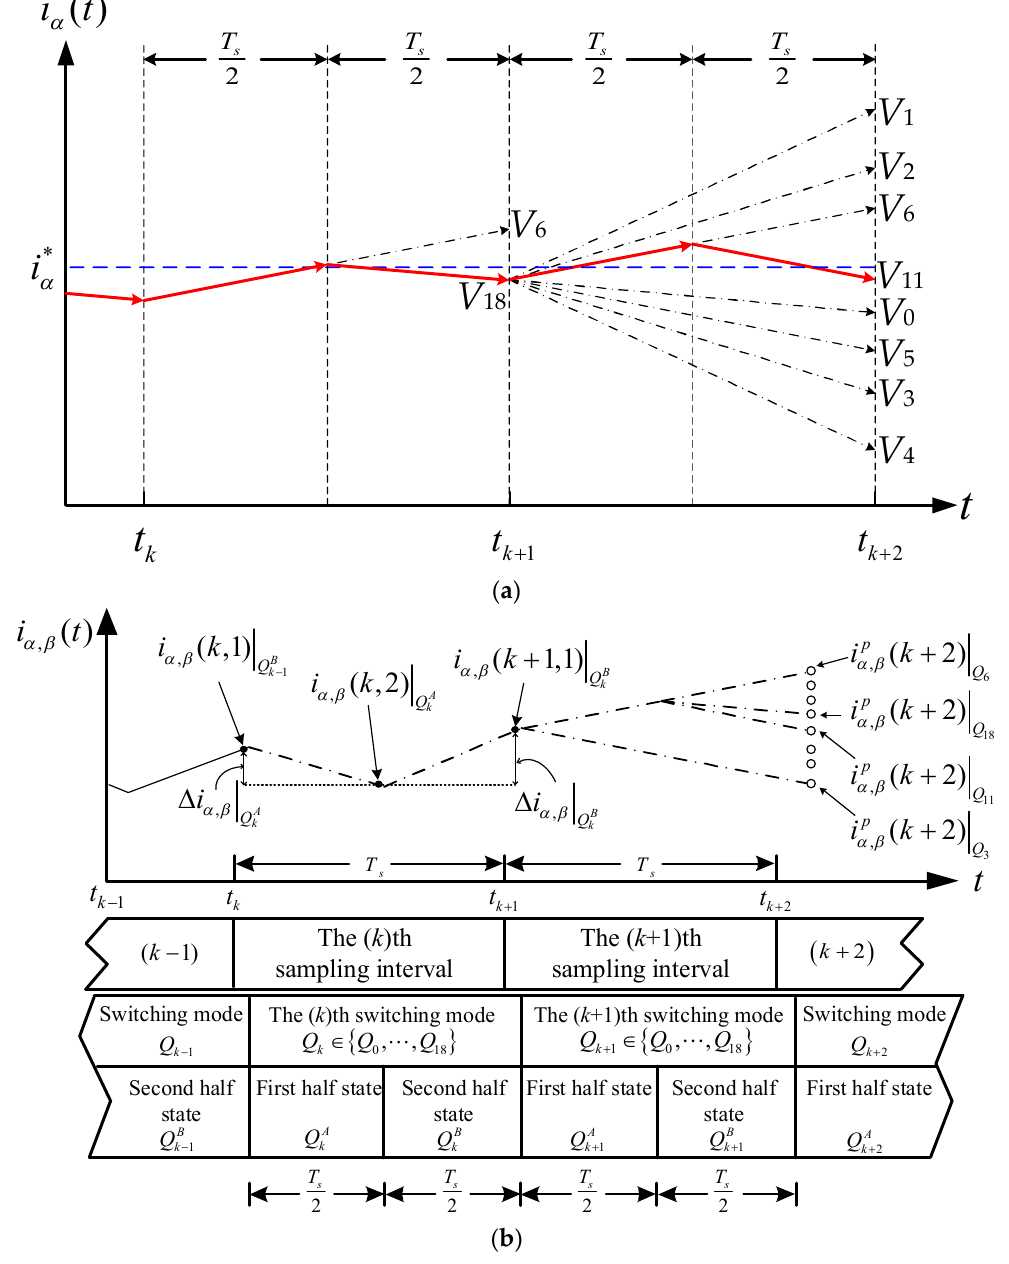
Figure 4. The features of dual-voltage-vector model-free predictive current control (DVV-MFPCC), including: ( a ) conceptual comparison of current prediction for the single-voltage-vector model-free predictive current control (SVV-MFPCC) [22] (black dashed line) and the proposed DVV-MFPCC (red solid line); ( b ) two current samples and two applied switching states during one sampling interval.